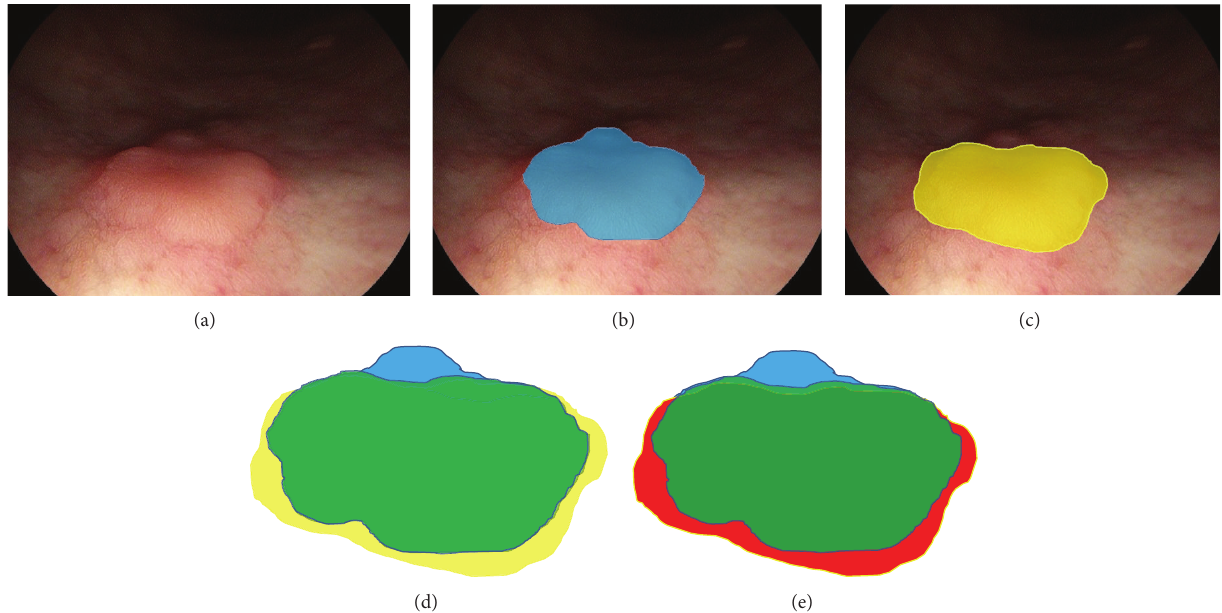
Figure 2: Assessment of demarcation accuracy. Endoscopic image of type 0-IIa gastric cancer in the greater curvature of the lower body.